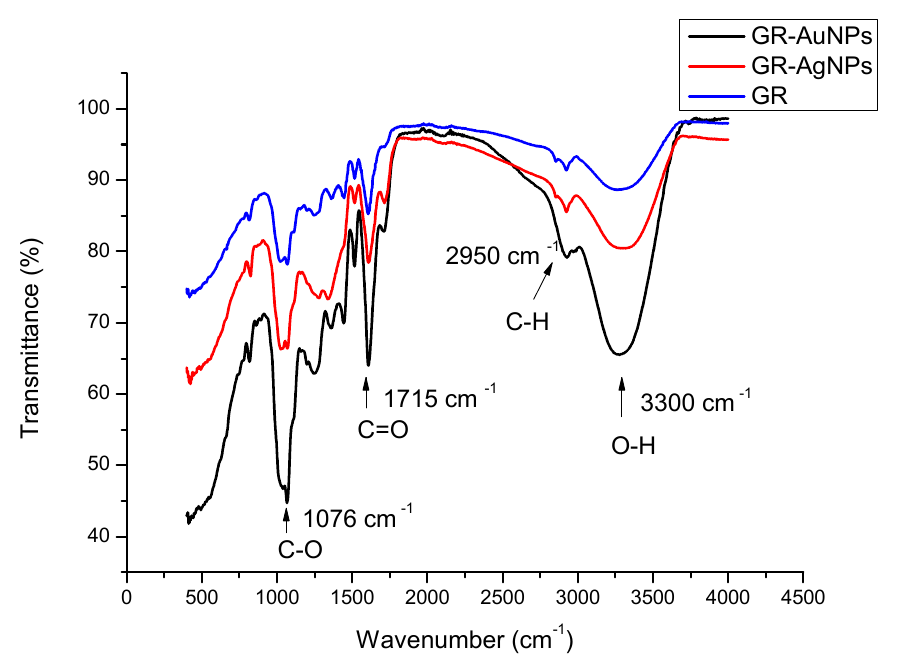
Figure 4. FTIR spectra of the GR, GR-AuNPs, and GR-AgNPs .